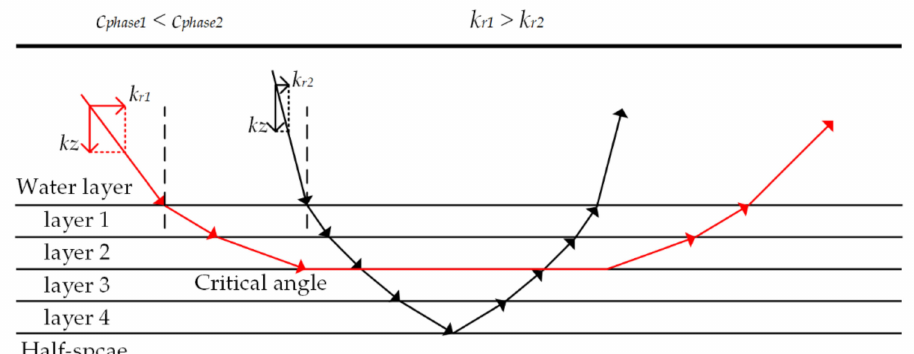
Figure 7. Plane waves with different incident angles propagating in the layered model. In the figure λ represents the wavelength of Scholte waves (The subscript 1 represents the high frequency and 2 represents the low frequency), and v si represents the s-wave velocity of the ith